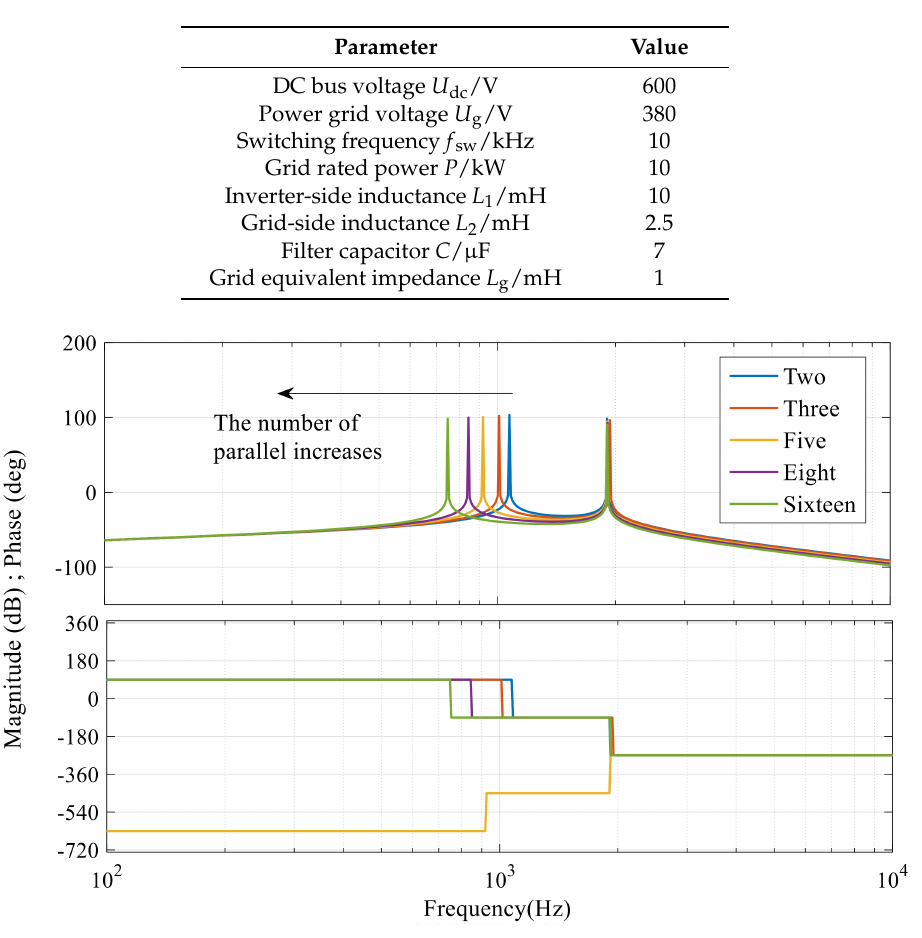
Table 1. Simulation parameters of photovoltaic grid-connected system.